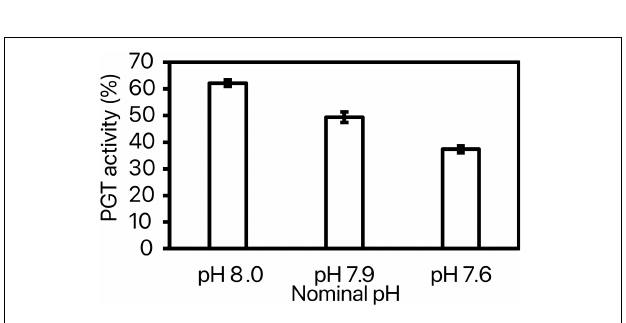
FIGURE 6 | Phenoloxydase (PO) activity measured at OD 492 of the 3 tested nominal pH NIST .